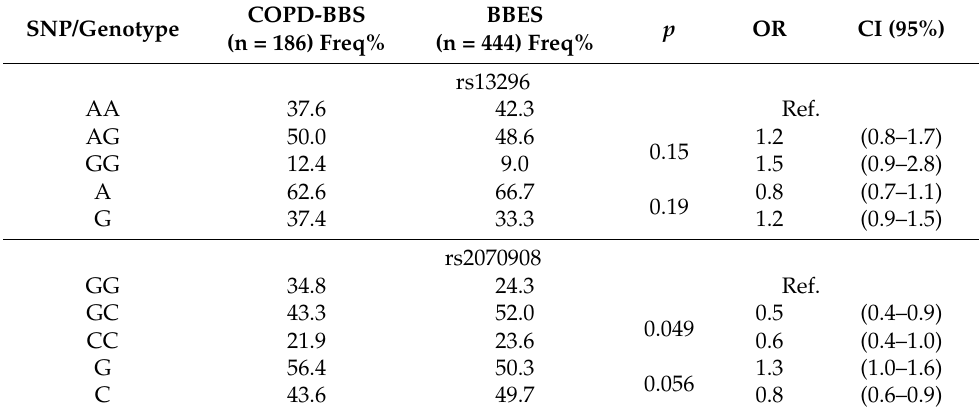
Table 5. Genotype and alleles frequency in biomass smoke-exposed